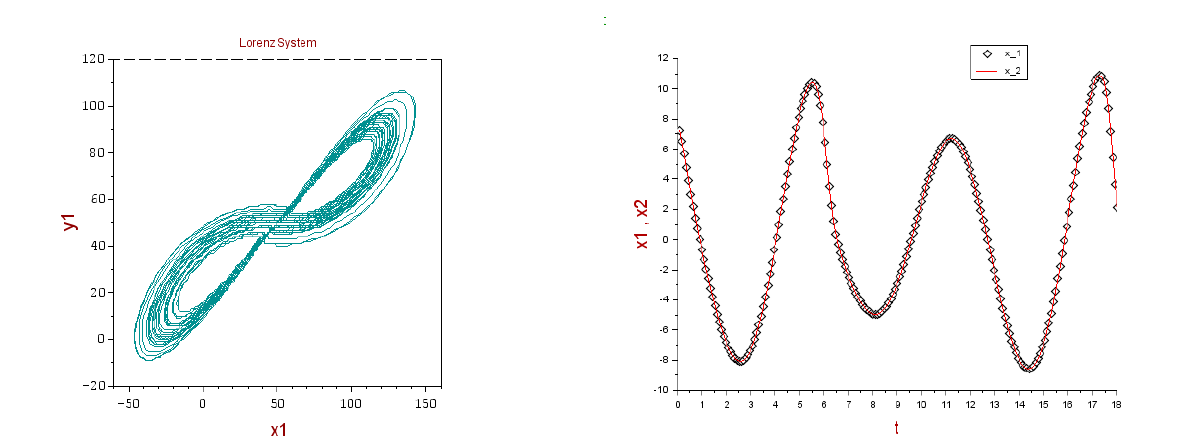
Figure 2. Time series for x 2 and x 1 for the coupling strengths k = 0 . 1 , 0 . 4 , 0 . 7,